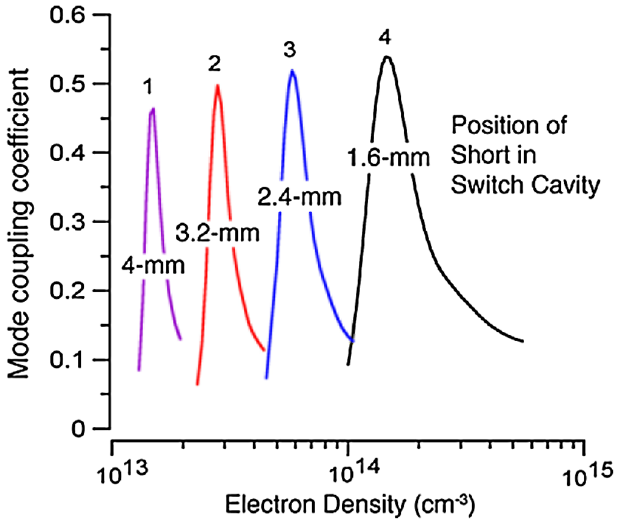
FIG. 11. (Color) Dependence of the coefficient of the TE mode conversion on electron density at different position of TE 01 adjusting short. Curve numbers mark different positions of the adjusting piston in the switch (switch settings).